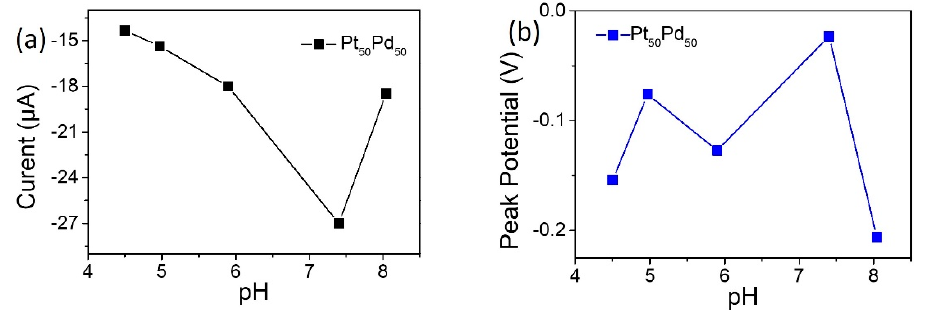
Figure 5. ( a ) CV peak currents of Pt 50 Pd 50 in PBS solutions with different pH comprising 1 mM concentration of H 2 O 2 . ( b ) Peak potentials of Pt 50 Pd 50 in PBS solutions with different pH comprising 1 mM concentration of H 2 O 2 .